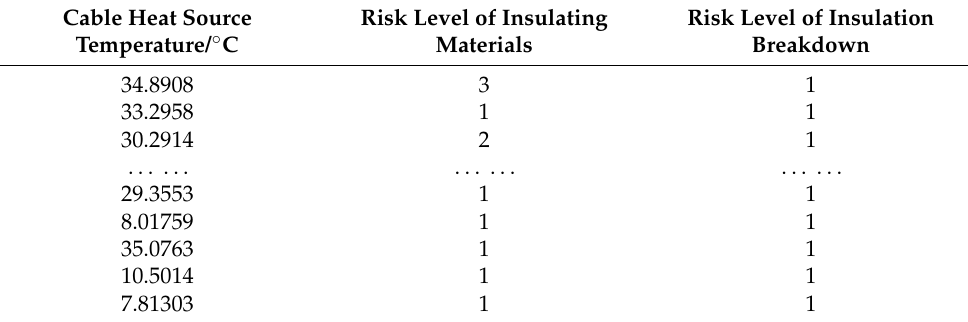
Table 6. Node states and risk factors generated by